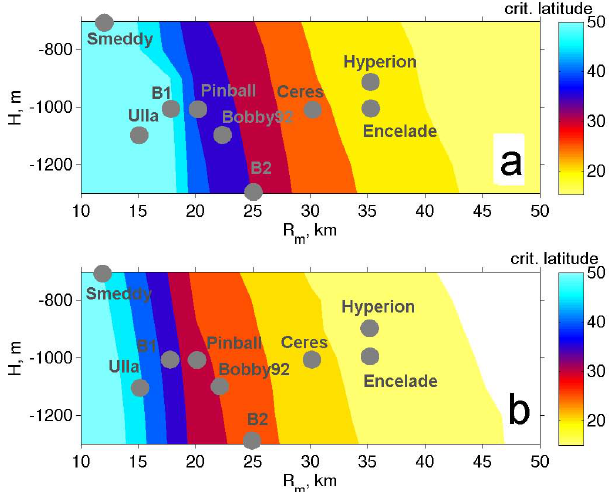
Fig. 9. Critical latitudes, presented as a function of meddy core depth H and of its dynamic radius R m , for critical ζ of 4cm (a) and of 2cm (b) . Meddies with a given set [ H,R m ] of characteristics are detectable in AVISO altimetry data at latitudes north of those pre- sented in the graph. The buoyancy frequency was obtained from the mean climatic density field (WOA09). Grey filled-in circles mark the meddies described in the text (Table